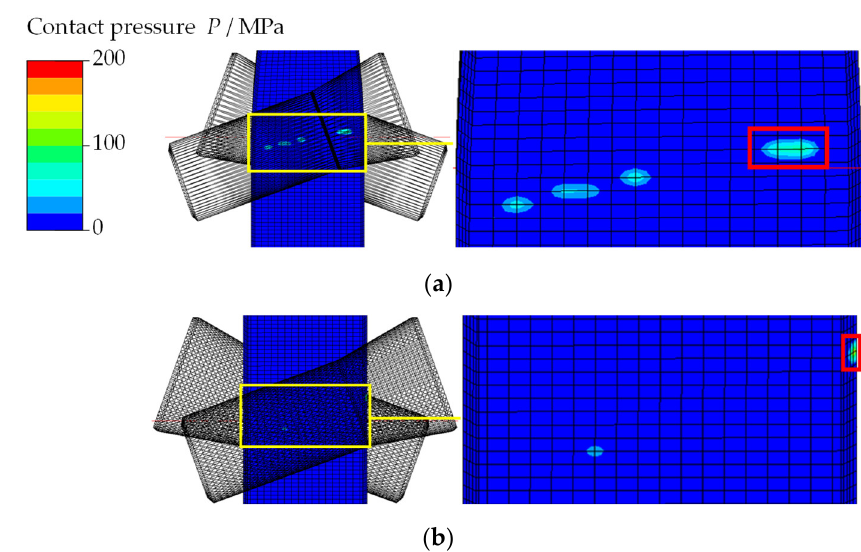
Figure 10. The effect of axial position on the twisted angle.